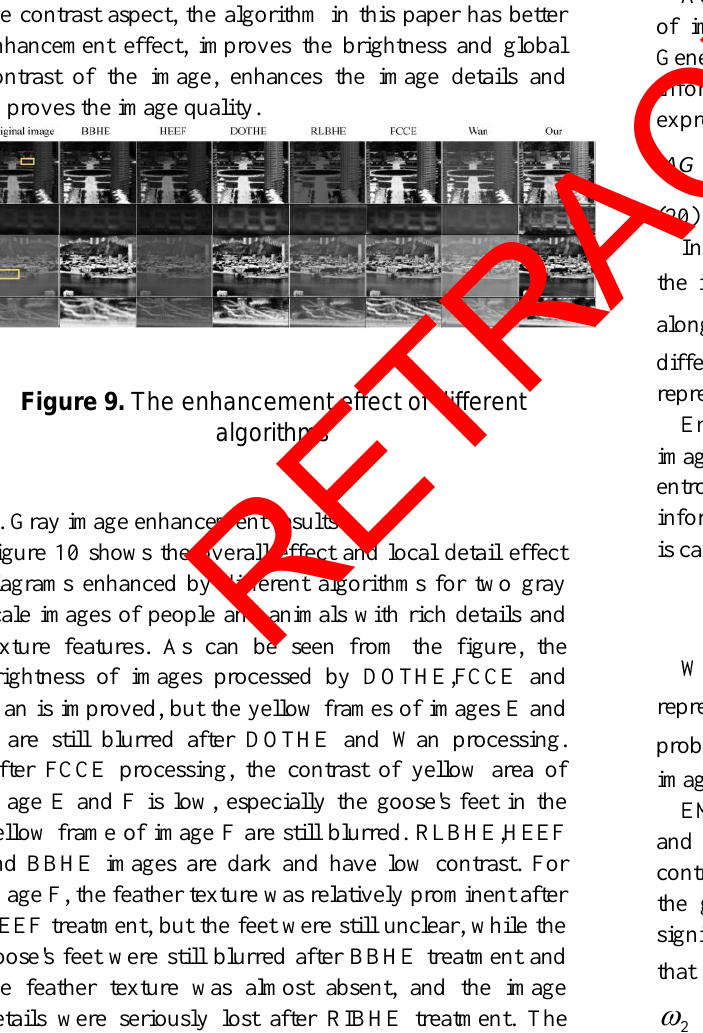
Figure 10. The enhancement image of different